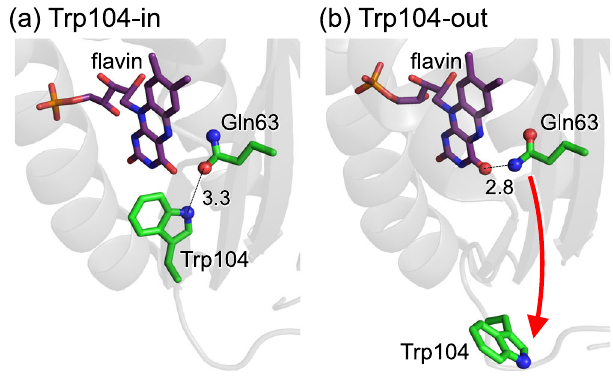
Fig. 6 Two Trp104 conformations in AppA BLUF domain. a Trp104 orienting toward the fl avin moiety (PDB ID 1YRX 17 ). b Trp104 orienting toward the bulk region (PDB ID 2IYG 18 ). Dotted lines indicate H-bonds. Values indicate distances (in Å). The red curved arrow indicates the Trp-in to Trp-out conformational change.